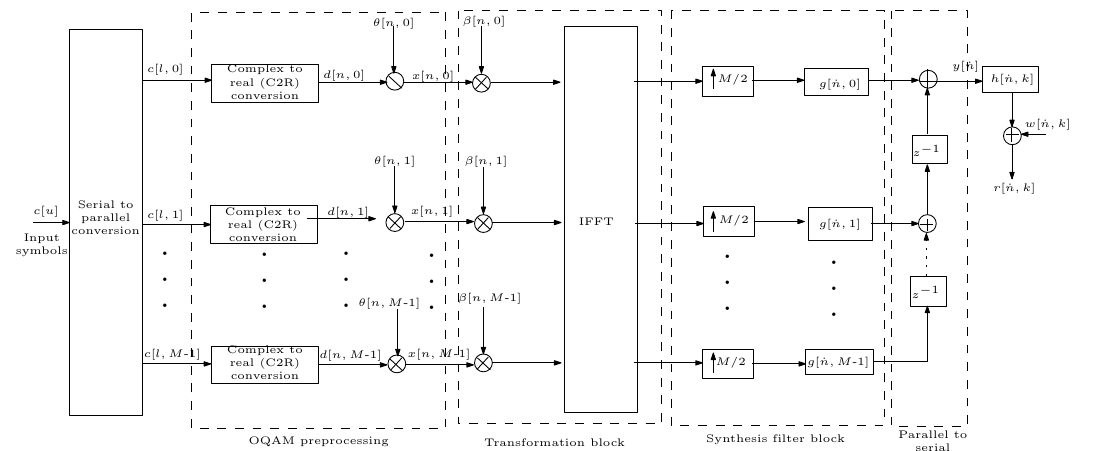
Figure 16. Structure of a filter bank OFDM-OQAM